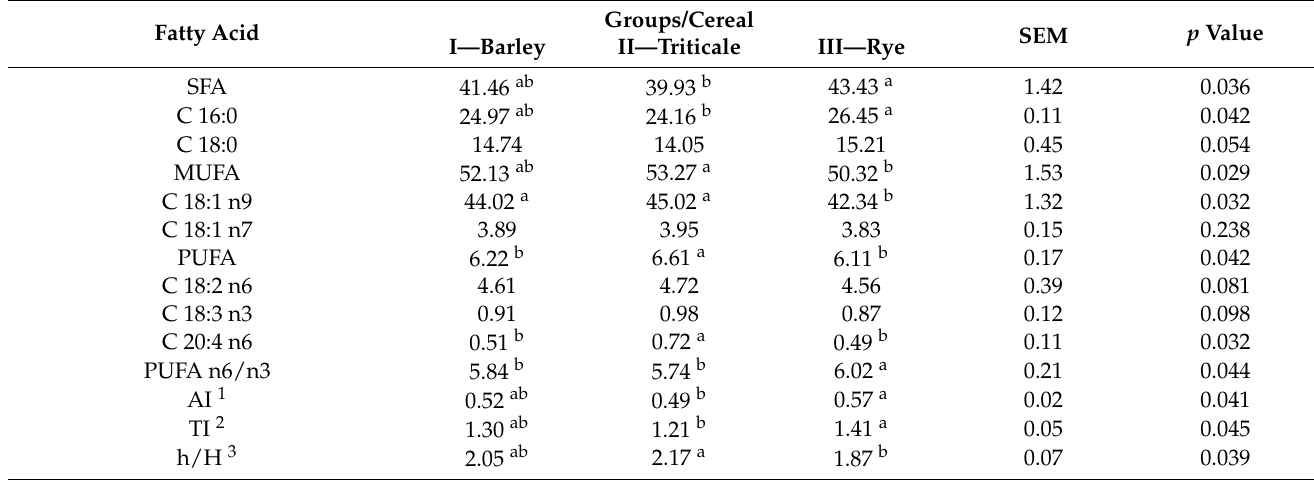
Table 8. Fatty acid composition (% of all estimated fatty acid) and indices of fat dietetic value in meat (musculus longissimus lumborum ).